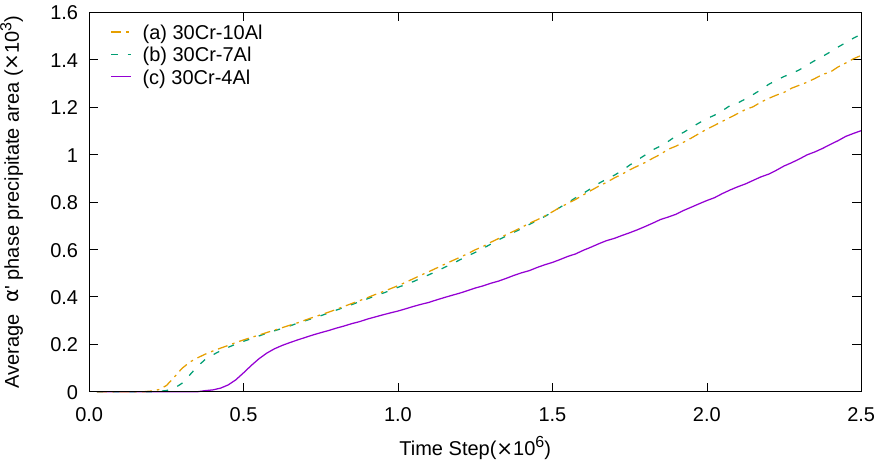
Figure 11. α (cid:48) phase fraction using the FactSage thermochemical software and FactSage steel (FSs- tel) database.